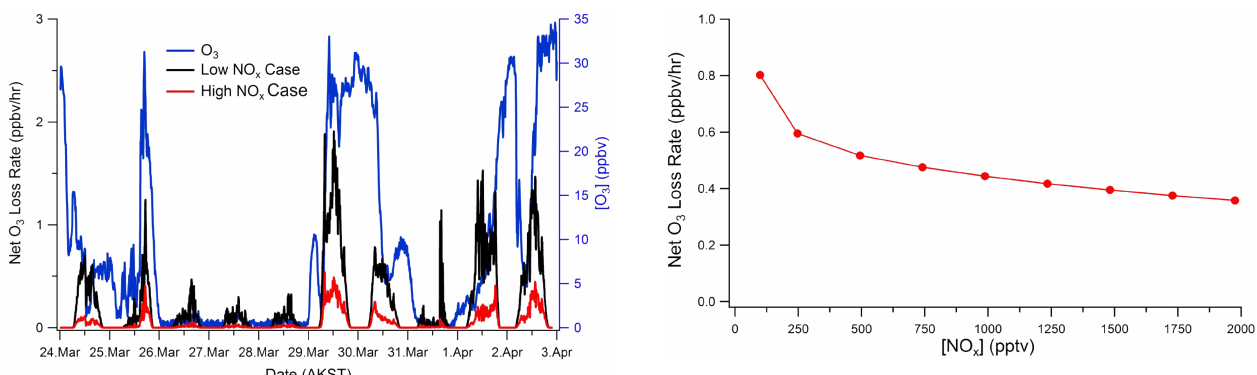
Figure 6. Net O 3 loss rate as a function of the NO x mixing ratio, for 30 March mid-day (11:00 to 13:00 AKST)